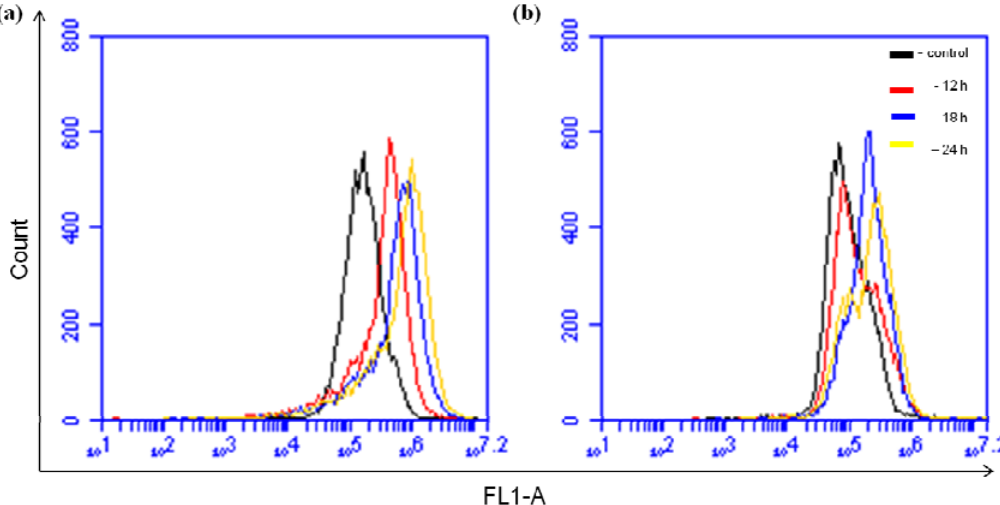
Figure 9. Effect of 50 µg/mL NRAF on caspase activities. ( a ) Indicated the flow cytometric fluorescence patterns of caspase-3/7. ( b ) Indicated the flow cytometric fluorescence patterns of caspase-9. ( c ) Effect of NRAF on the activation of caspase-3/7 in HT-29 cells. ( d ) Effect of NRAF on the activation of caspase-9 in HT-29 cells. Both caspase activities were assessed in time-dependent manner (12, 18 and 24 h) at 50 µg/mL of NRAF. The data expressed as mean ± S.E. from three individual experiments. Asterisks indicate significantly different value from control ( * p <